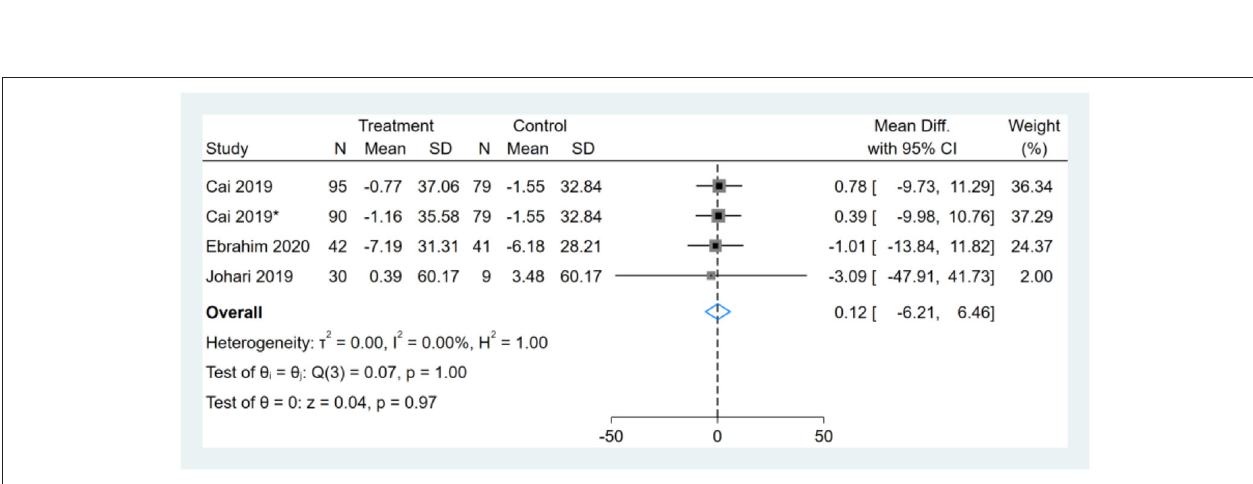
FIGURE 13 | Forest plot analysis showing changes in low-density lipoprotein cholesterol (LDL-C). *This study has two fasting intervention groups.